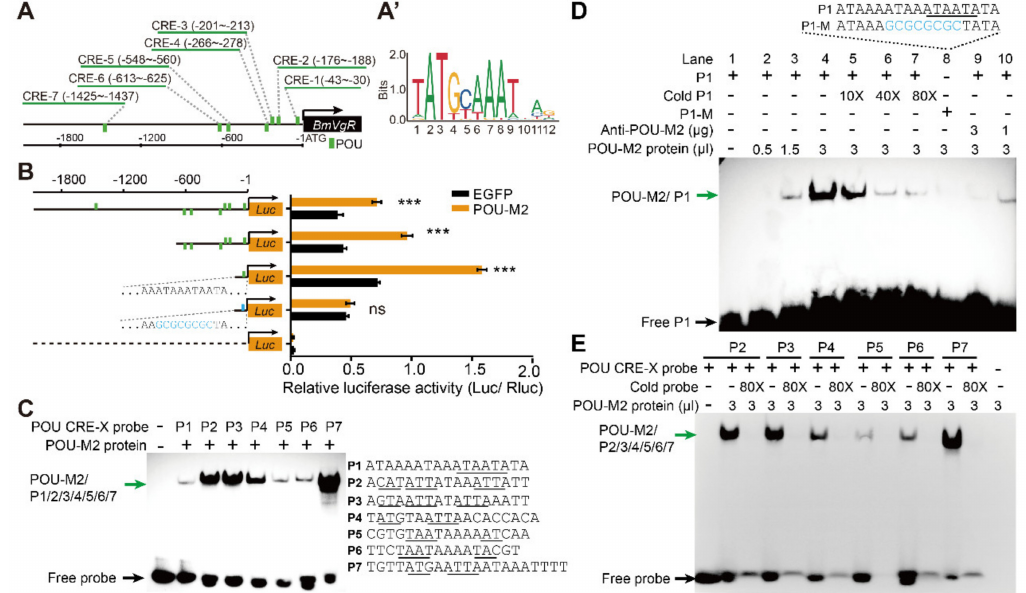
Figure 3. POU-M2 activates the expression of BmVgR by directly binding to its promoter. ( A ): Seven putative POU CREs in the BmVgR promoter region (Green boxes). ( A’ ): Putative conserved sequences of POU elements from JASPAR 2020 . ( B ): E ff ect of overexpression of POU-M2 on the activity of truncated and mutated BmVgR promoters ( C ): EMSA assays performed to evaluate the binding of the seven POU element probes (P1 / P2 / P3 / P4 / P5 / P6 / P7) and POU-M2 protein. Probe sequences are shown on the right and possible core binding sites of POU elements are underlined. ( D ): Binding of POU CRE-1 to the POU-M2 protein with cold probe, mutant probe, and anti-POU-M2 antibodies. Light blue represents the mutated sequence of POU CRE-1. ( E ): Competitive binding of POU CRE-2 / 3 / 4 / 5 / 6 / 7 to the POU-M2 protein with an 80-fold cold probe excess. All data represent three biological replicates with three technical replicates; error bars indicate SEM ranges ( n = 3). *** p < 0.001 (Student’s t test). ns: not